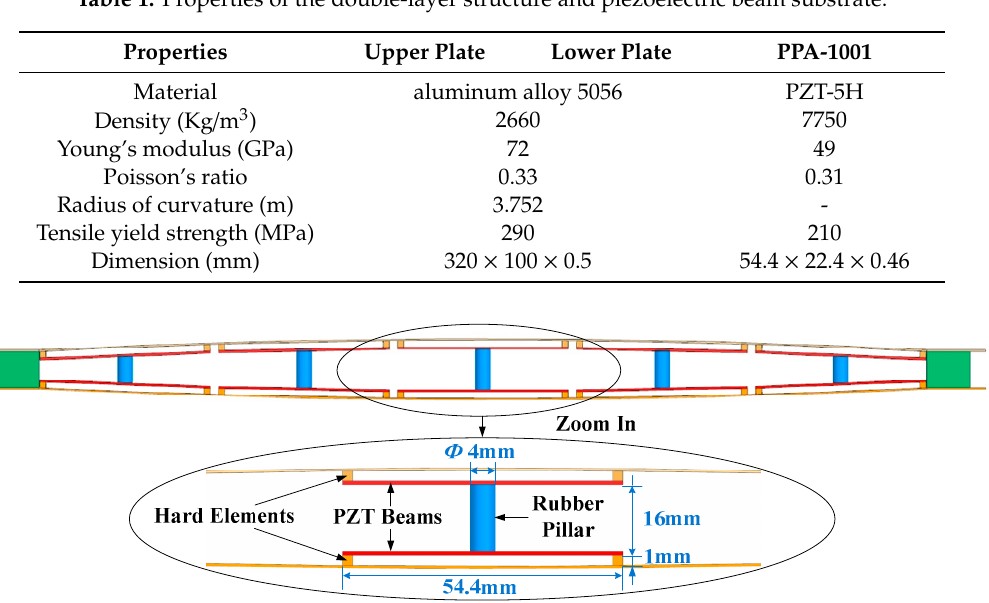
Figure 3. A close view of the structure of piezoelectric clamped–clamped beam.